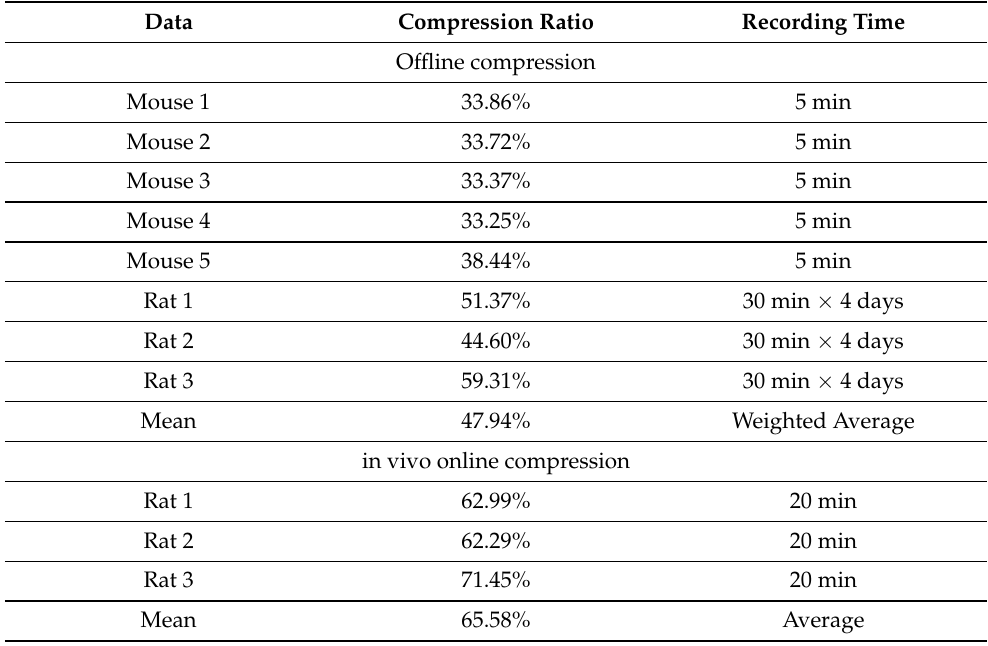
Table 2. Compression ratios, in the percentage of the original signal size, for the different datasets not related to dictionary creation.